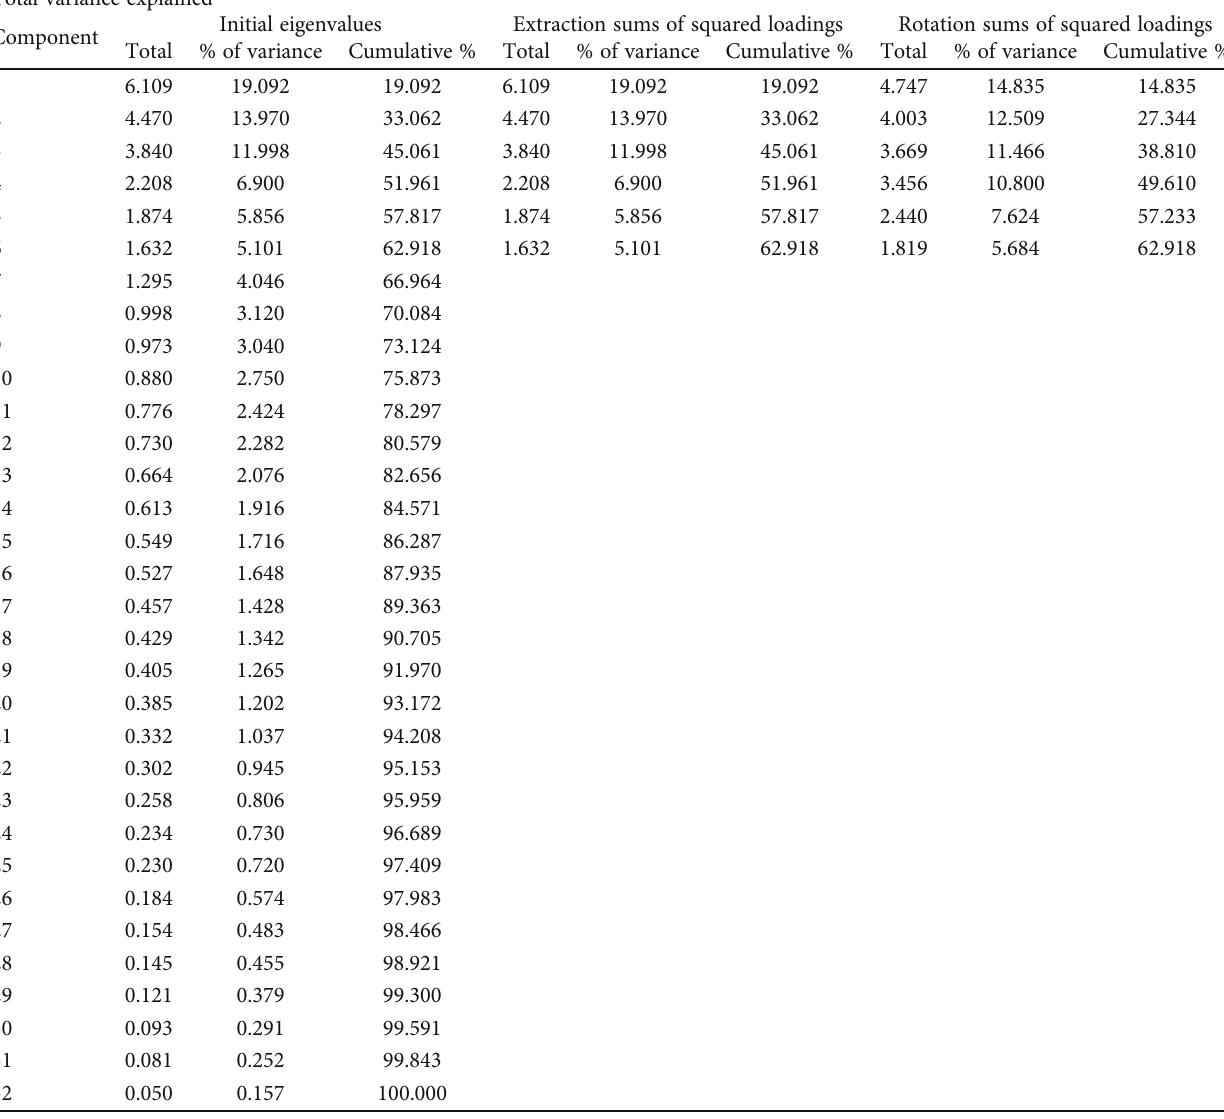
Table 4: Factors extracted after exploratory